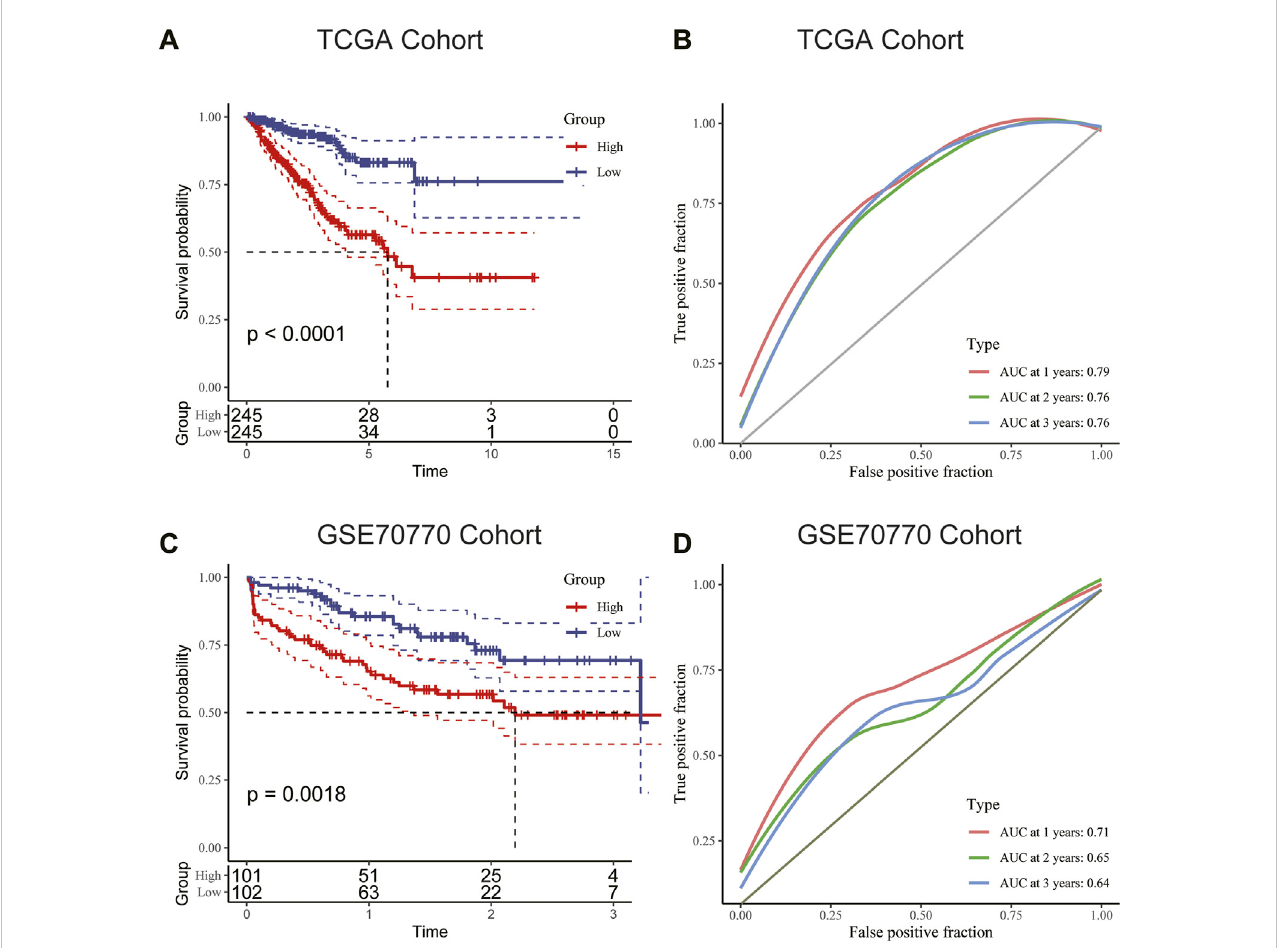
FIGURE 6 (A) Kaplan – Meiersurvivalanalysissuggestedthatpatientsinthehigh-riskgroupweremorepronetorecurrenceinthetrainingcohort. (B) TheAUCcurve plottedbyROCanalysisofthesignaturerevealedthatthepredictiveperformanceofthesignaturewasgood. (C) Kaplan – Meiersurvivalanalysissuggestedthat patients in the high-risk group were also more prone to recurrence in the validation cohort. (D) The AUC curve plotted by ROC analysis of the signature was also presented in the validation